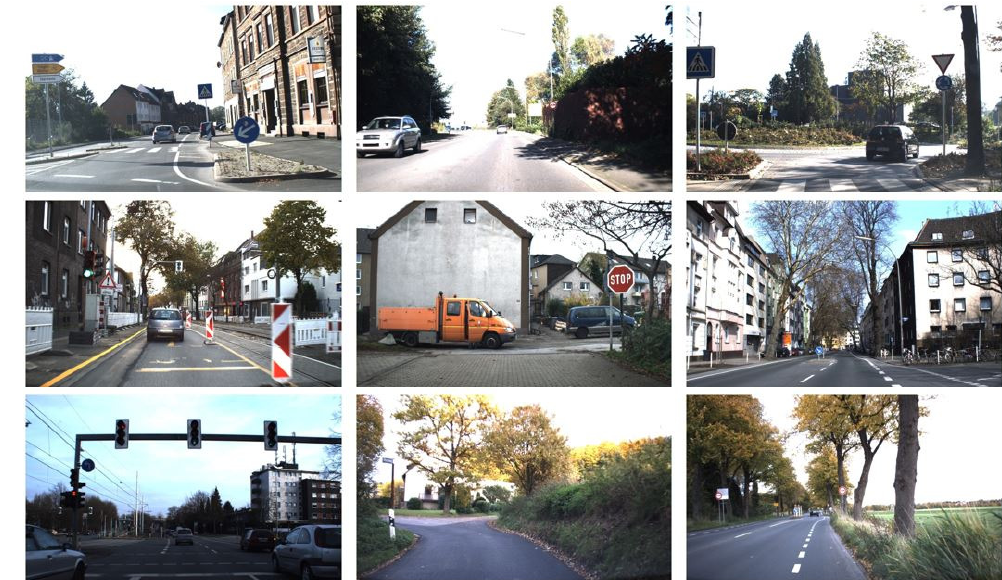
Figure 6. Examples from the GTSDB